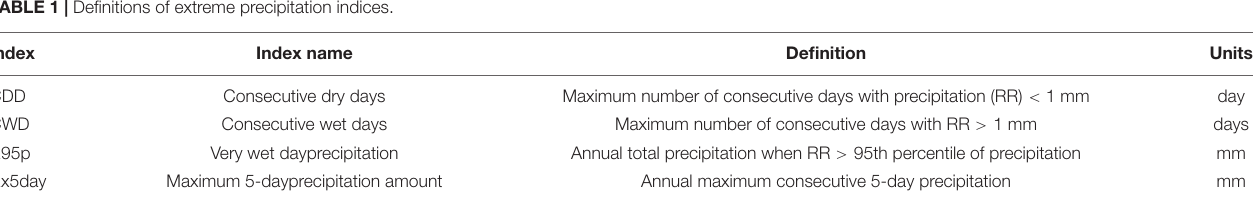
TABLE 1 | Definitions of extreme precipitation